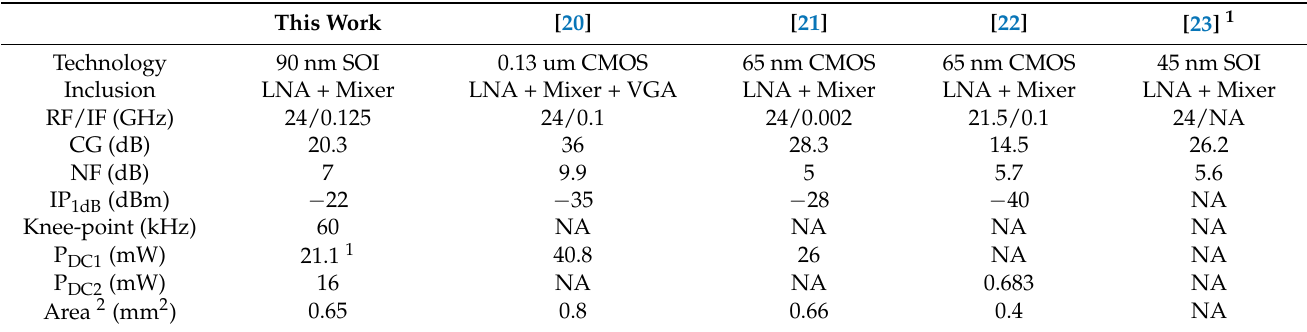
Table 2. Performance comparison